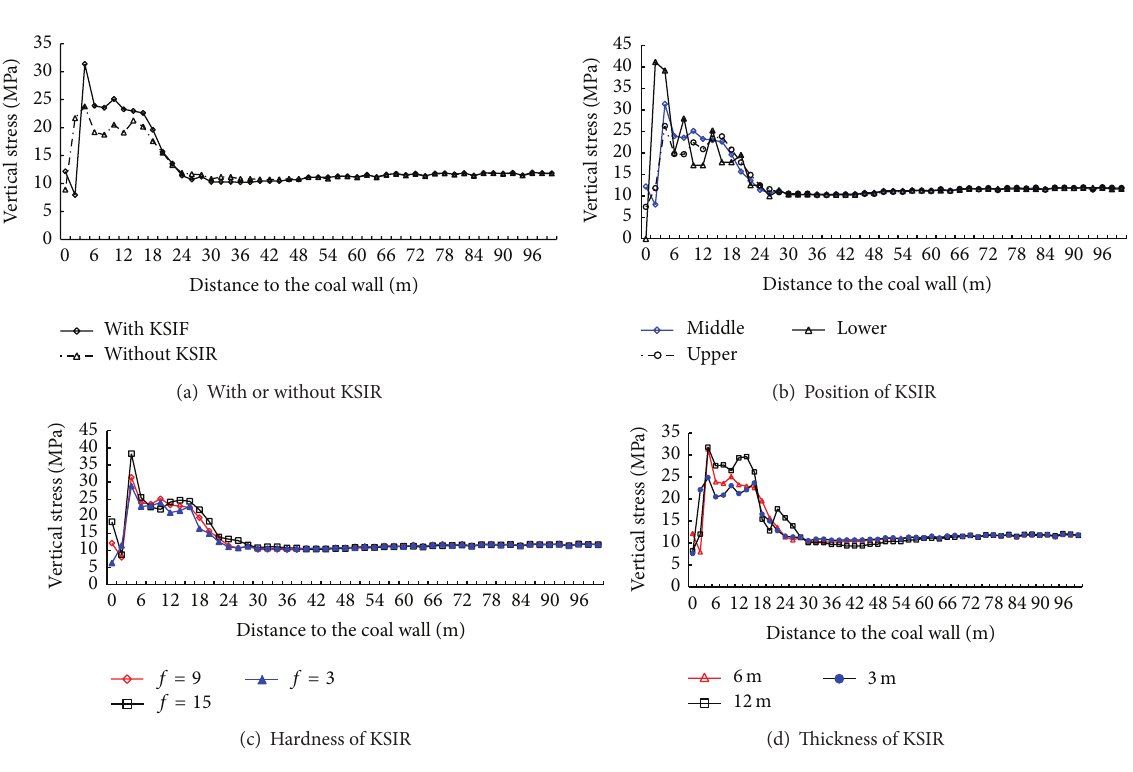
Figure 9: Effect on distribution of abutment pressure of